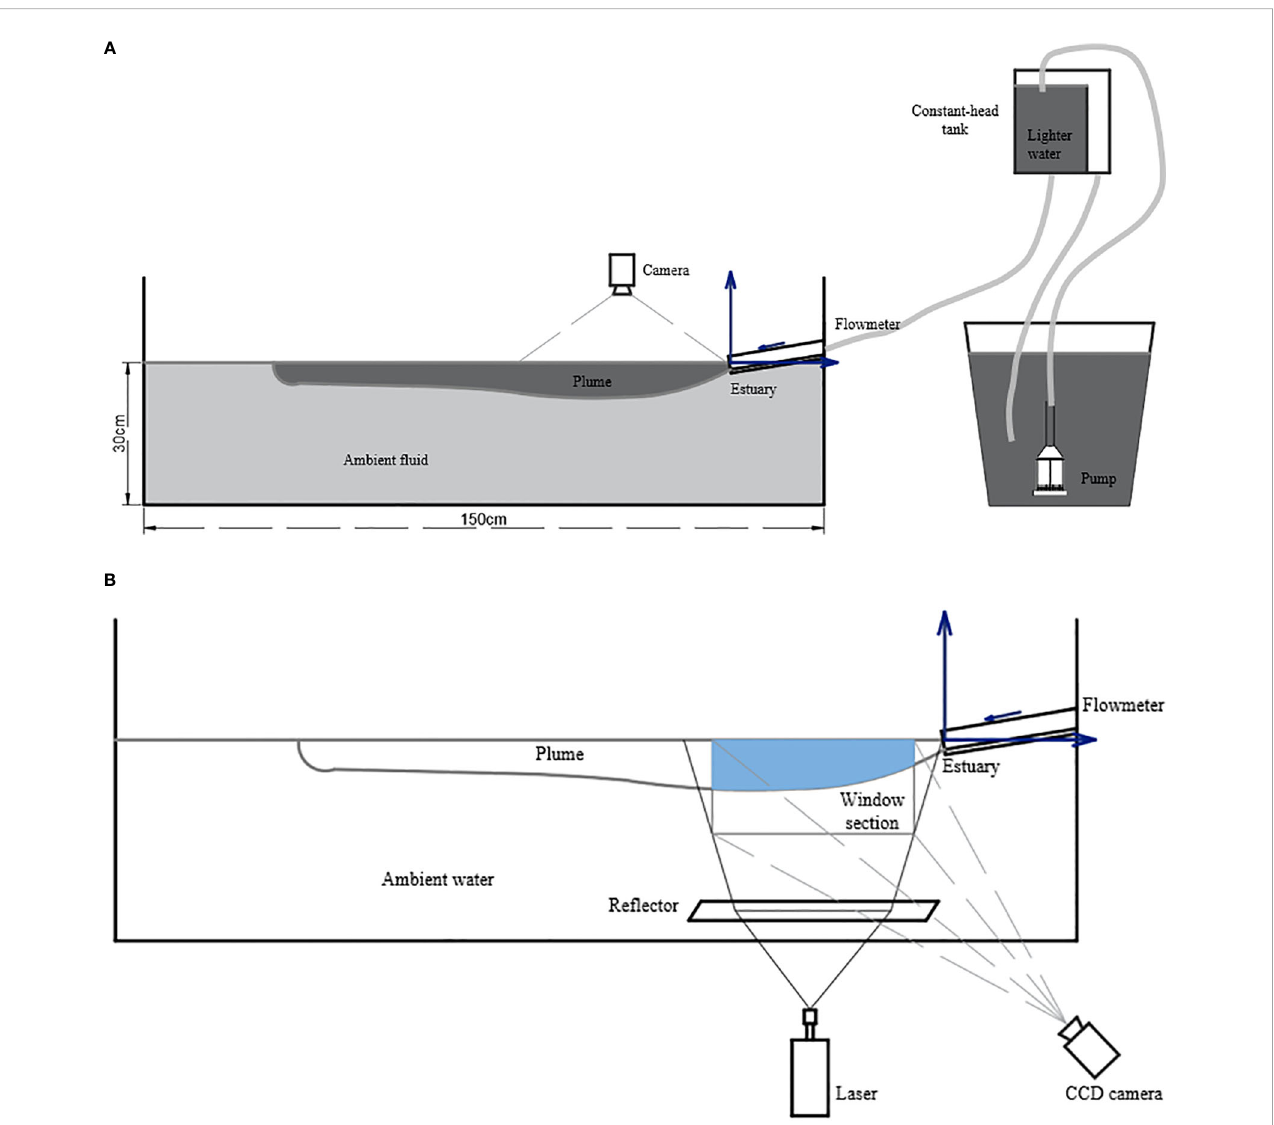
FIGURE 1 Diagram of the experimental setup: qualitative plan-view experiment (A) and qualitative and quantitative side-view experiment (B)